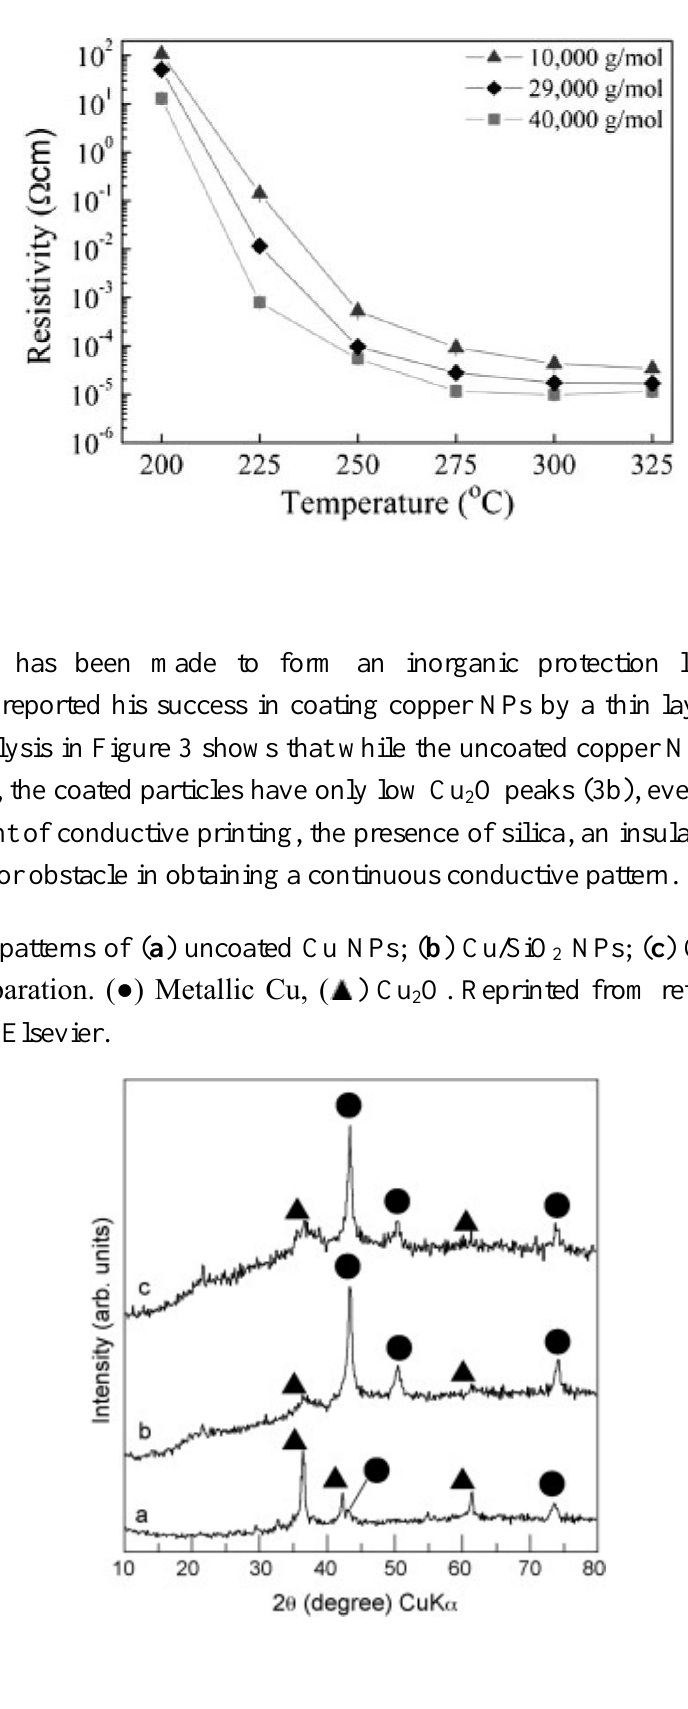
Figure 2. Resistivity of the Cu conductive film as a function of heat treatment temperature for various PVP MWs. The ink-jet printed Cu nanoparticulate films were heat-treated at various temperatures between 200 °C and 325 °C under vacuum. Reprinted from [40], Reproduced with permission of copyright Wiley-VCH Verlag GmbH and Co. KGaA.